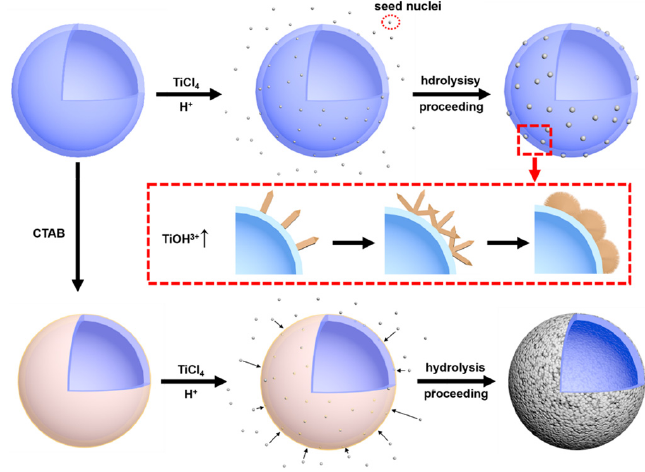
Figure 6. Schematic illustration of the possible formation process of the needle-shaped rutile nanorods shell on the HGM surface.